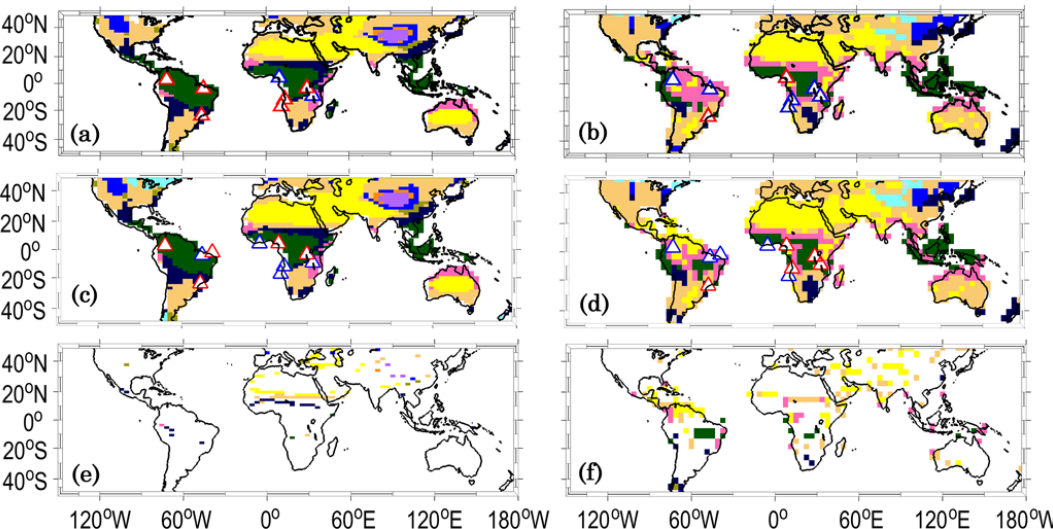
Fig. 5. The biome distributions computed from the simulations of LGM UVic (a) , LGM CCSM (b) , HE1 UVic (c) and HE1 CCSM (d) . A comparison between model output and biome reconstruction of each location for the period of LGM and HE1 is indicated by white- blue triangles where biomes computed from the model are similar to the reconstruction; white-red triangles denote where modelled and reconstructed biomes differ. Anomalies of biome distribution between the HE1 and LGM simulations of the UVic ESCM (e) and the CCSM3 (f) . The anomaly shows the HE1 biome (from the HE1 UVic and the HE1 CCSM simulations) only in those grid cells that differ from the LGM simulations LGM UVic and LGM CCSM, respectively. See Fig. 4 for biome distribution legend.